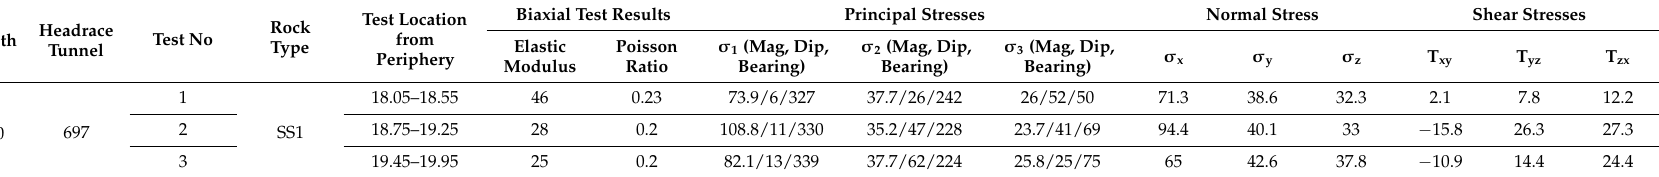
Table 3. Results of in situ stresses from overcoring (measured in tunnel boring machine-excavated headrace tunnel